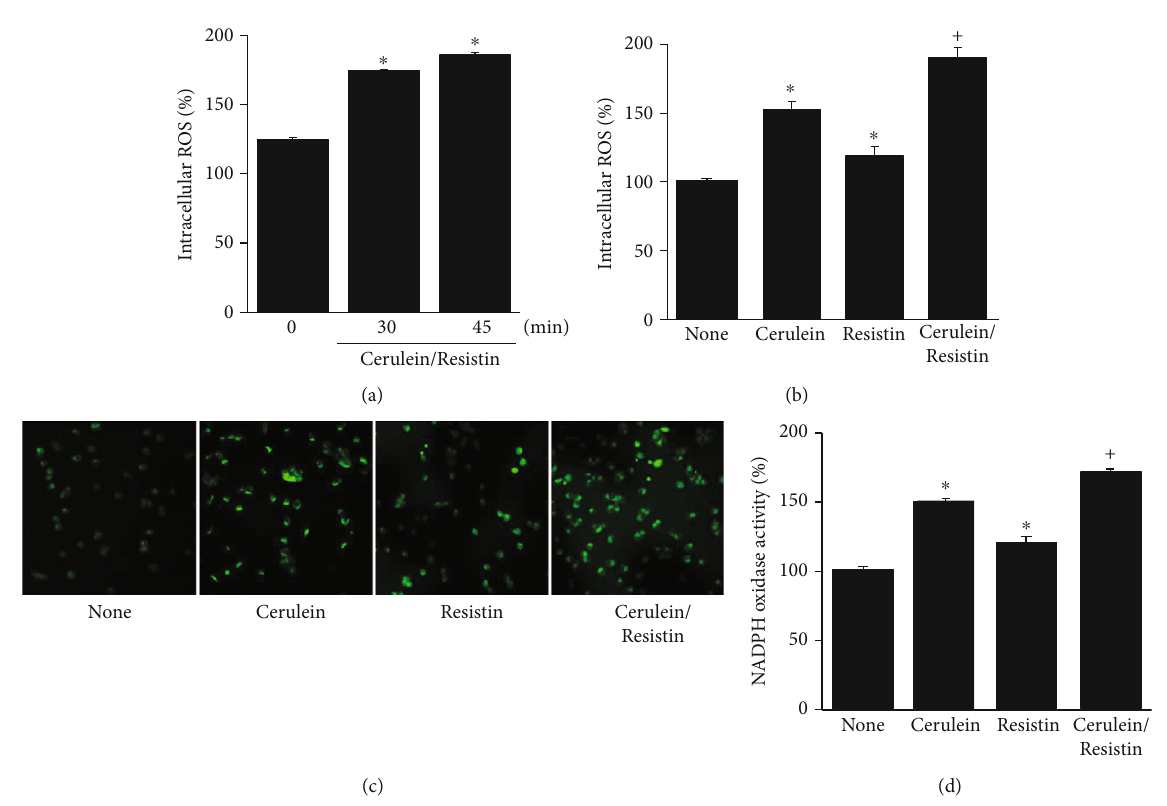
Figure 1: Resistin enhances cerulein-induced reactive oxygen species (ROS) production and NADPH oxidase activation in AR42J cells. (a) The cells were stimulated with cerulein/resistin for the indicated times. (b – d) The cells were stimulated with cerulein with or without resistin for 45min. (a, b) Intracellular ROS levels were measured by dichloro fl uorescein diacetate (DCF-DA) fl uorescence. ROS levels were expressed as the relative increase. (c) Representative images of ROS-induced fl uorescence response of DCF-DA. (d) NADPH oxidase activity in membrane fractions was measured by the lucigenin assay. Data are expressed as the mean ± S : E . of three di ff erent experiments. The value for cells without cerulein stimulation in the absence of resistin treatment (none) is set as 100%. ∗ p < 0 : 05 vs. 0 min (a) or none (untreated cells; b, c); + p < 0 : 05 vs. cerulein (cells treated with cerulein